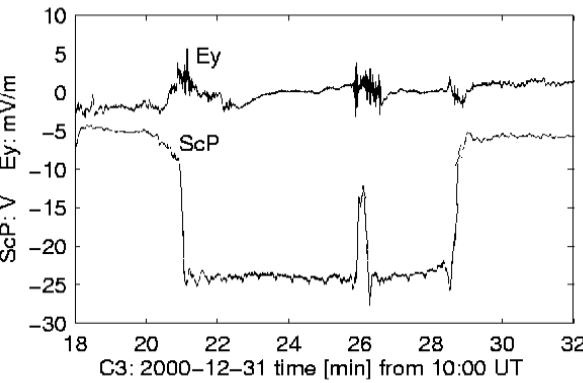
Fig. 10. Electric field component and spacecraft potential at a se- quence of magnetopause crossings. Strong electric field turbulence is co-located with the boundary crossings (density gradients).